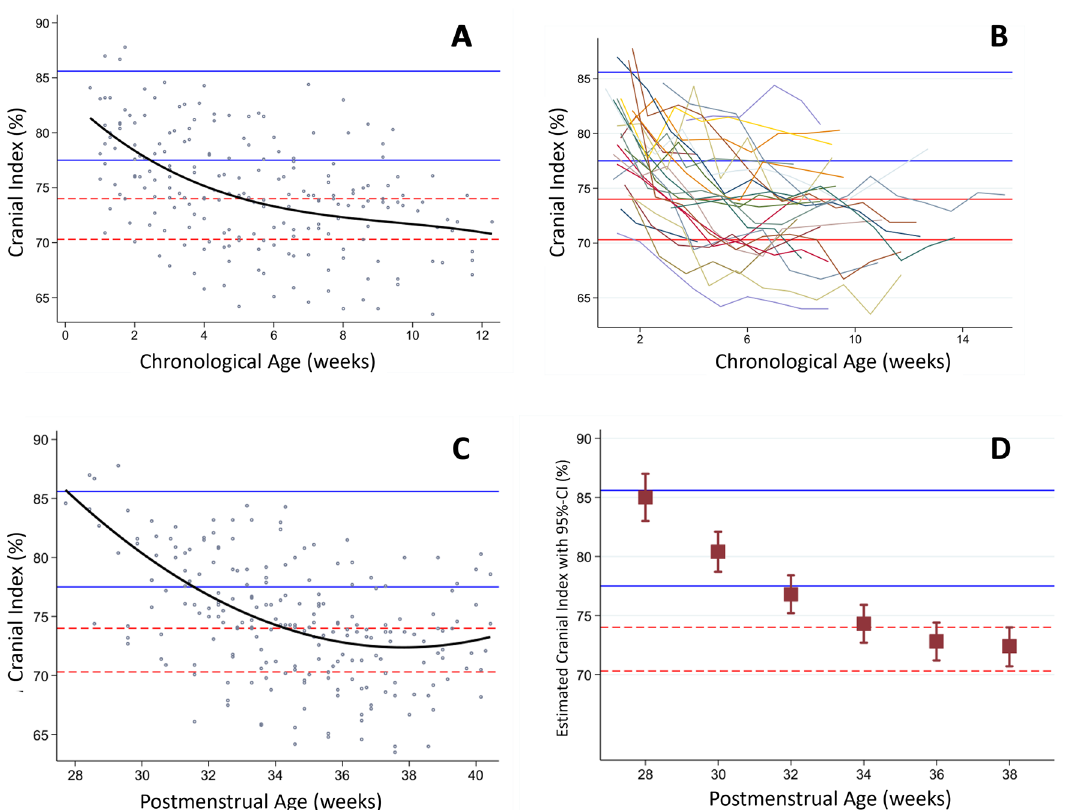
Figure 3. Longitudinal evolvement of cranial index in relation to chronological ( A,B ) and postmenstrual age ( C,D ). Scatter plots of all measurements (n = 217) with 3rd ( A ) and 2nd ( C ) degree polynomial regression, individual cranial index graphs ( B ) and estimation of 2nd ‐ degree polynomial coefficient with 95% confidence interval (95% CI ( D )). Mild brachycephaly (above upper blue bar; cranial index 85.6 to 89.5%), normal head morphology (between blue bars; cranial index > 77.5 to < 85.6%), mild dolichocephaly (between lower blue and upper red bar; cranial index 74–77.5%), moderate dolichocephaly (between red bars; cranial index 70.3 to < 74%), severe dolichocephaly (below lower red bar; cranial index < 70.3%). Reference values as defined above 13,14